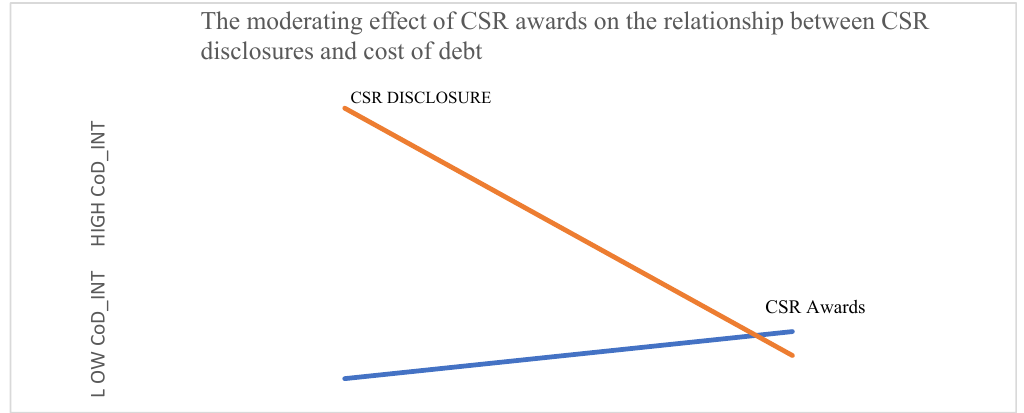
Figure 1. The moderating effect of CSR awards on the relationship between CSR disclosures and the cost of debt.